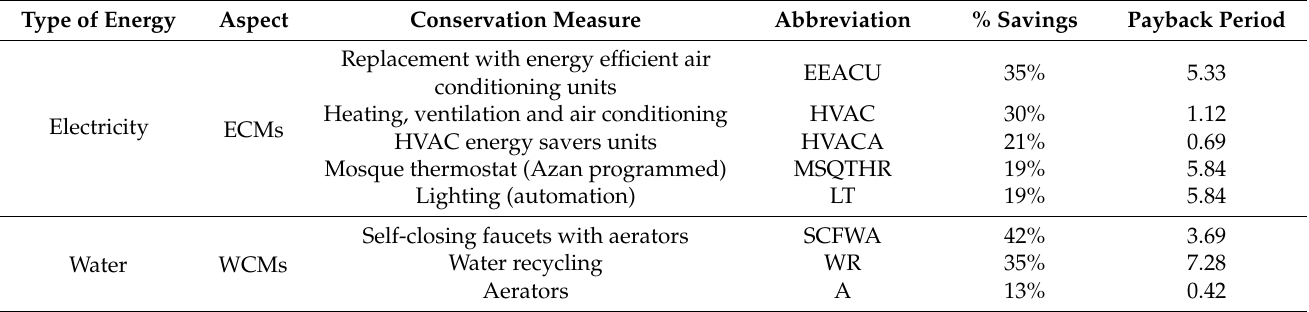
Table 11. Summary of the most energy-efficient and cost-effective energy conservation measures (ECMs) and water conservation measures